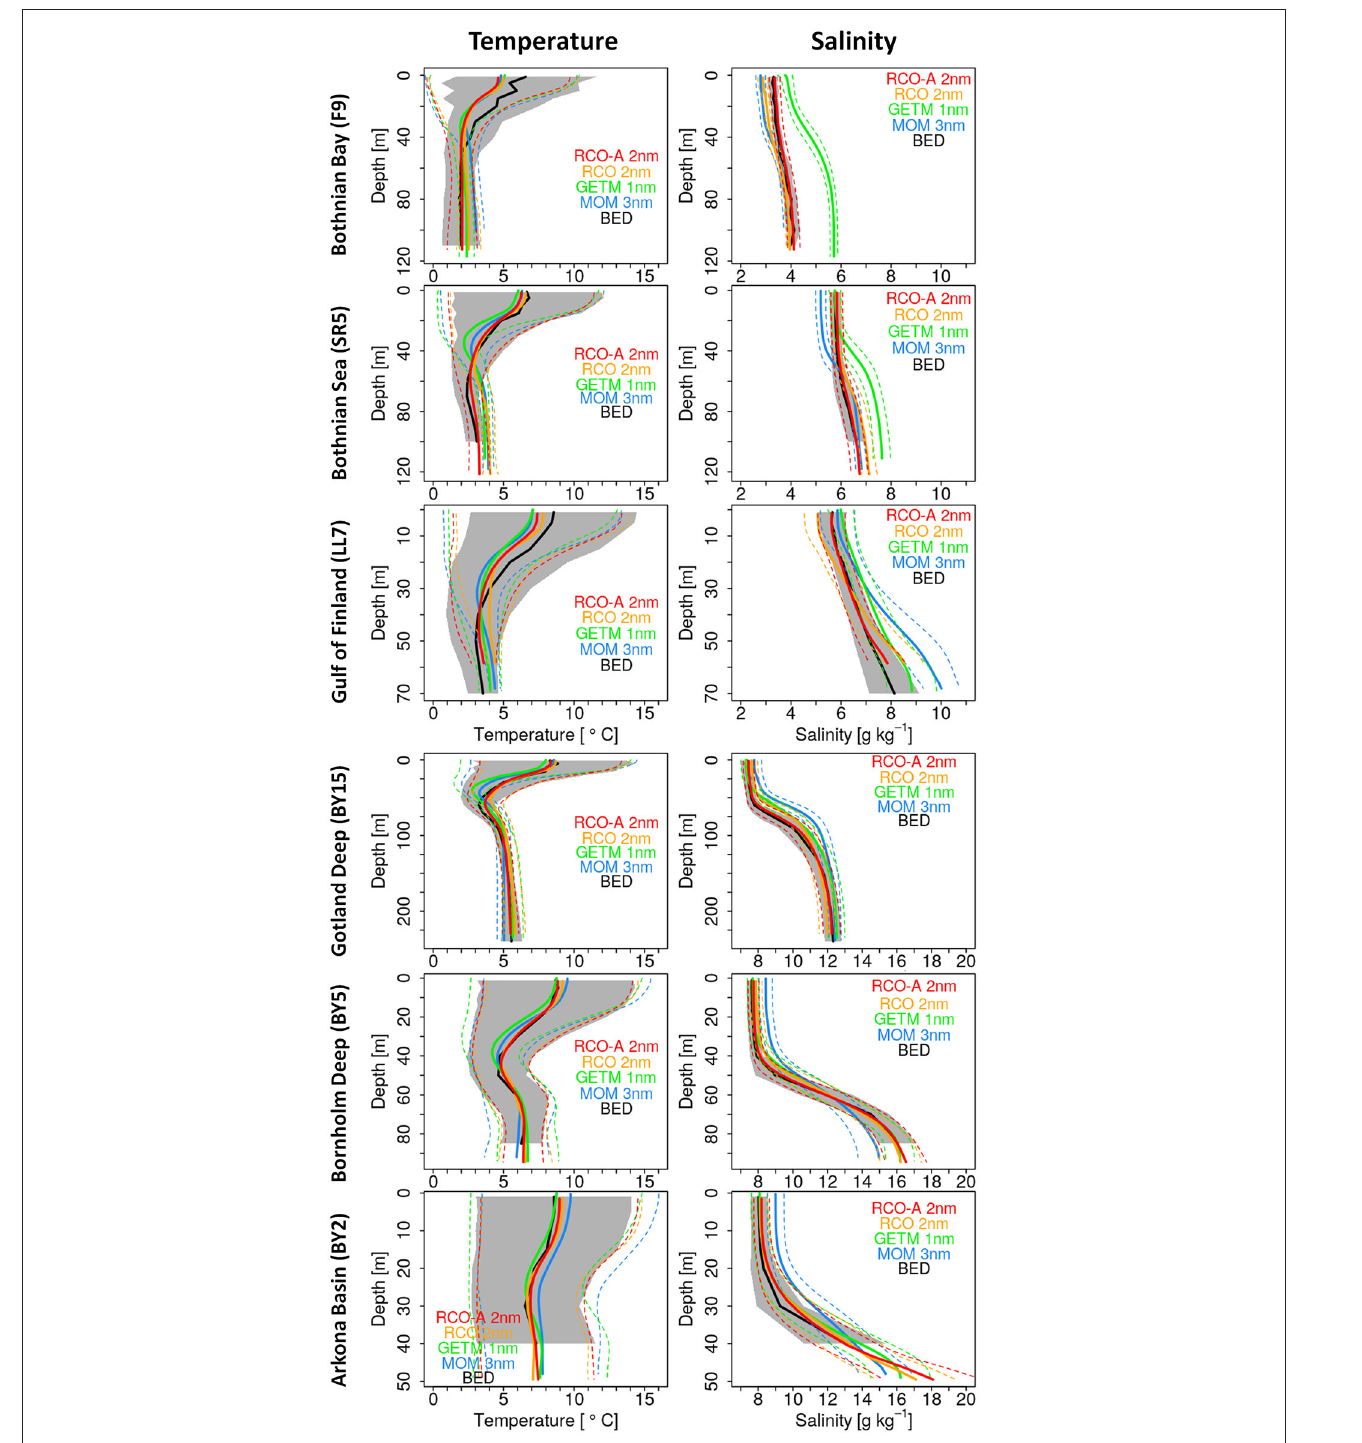
FIGURE 2 | Thirty-year mean vertical profiles of sea temperature ( left ) and salinity ( right ) from BED observation data (black) and the ocean models RCO-A (red), RCO (orange) both with 2nm horizontal resolution, GETM (green) with 1nm resolution, and MOM (blue) with 3nm resolution for the time period from 1970 through 1999. Results for the monitoring stations BY2 in the Arkona Basin, BY5 at Bornholm Deep, BY15 at Gotland Deep, LL7 in the Gulf of Finland, SR5 in the Bothnian Sea, and F9 in the Bothnian Bay are displayed from bottom to top. Mean values are illustrated by solid lines. Standard deviations are indicated by the gray-shaded area for the BED data and by the colored dashed lines for the models. The depth ranges are adjusted to the maximum water depth at each station and therefore differ for the individual stations. Note, that the value range for salinity is different for the southern and the northern stations.